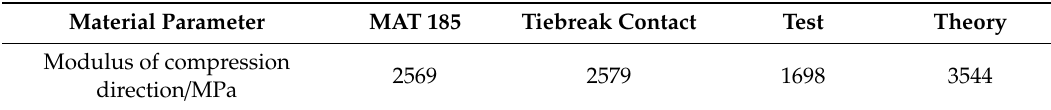
Table 1. Comparison of simulation, experiment, and theoretical results with modulus. Material Parameter MAT 185 Tiebreak Contact